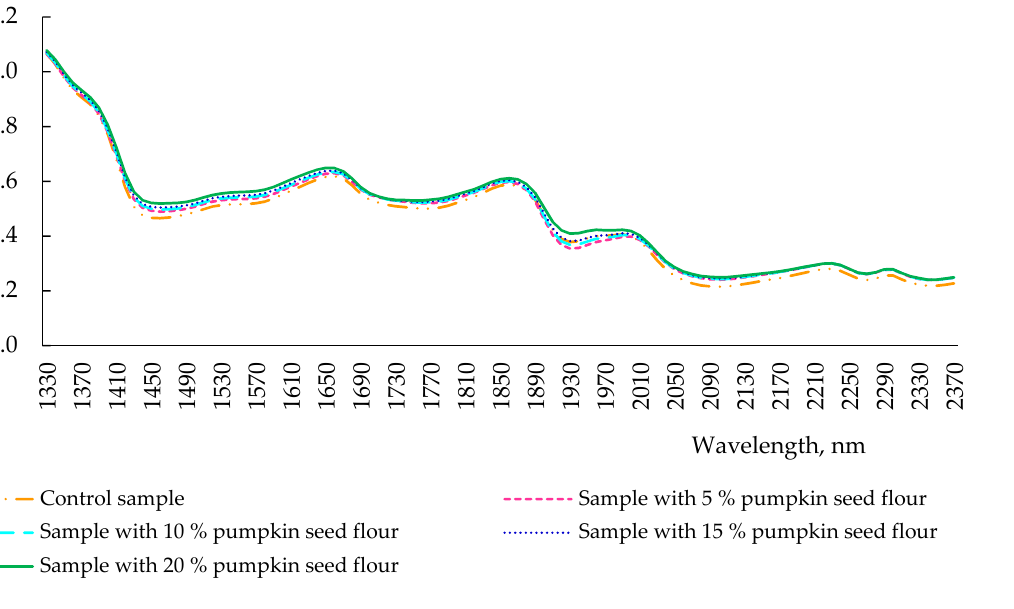
Figure 5. Spectra of reflection of bread with pumpkin seed flour at different concentrations (0, 5, 10, 15, and 20%).